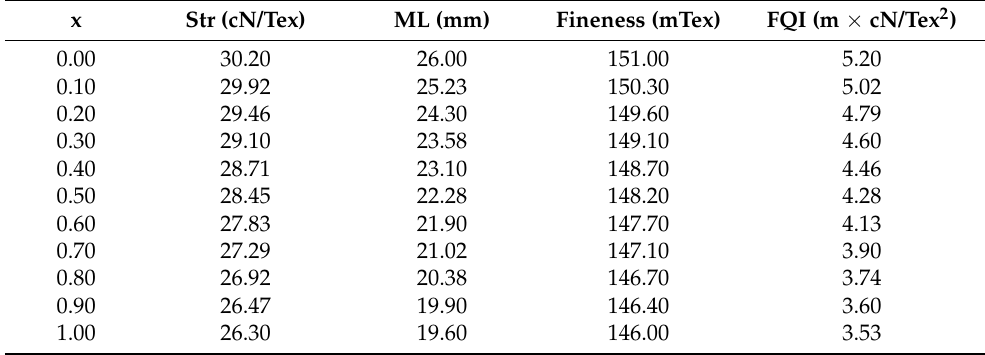
Table 2. FQI for the V1 and W1